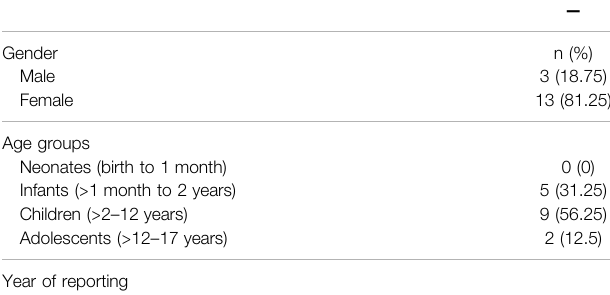
TABLE 1 | Characteristics and assessment of paediatric patients ADR reports.